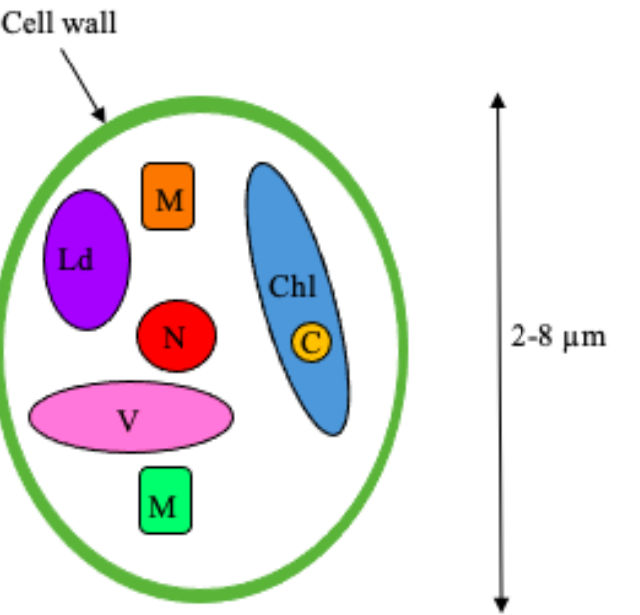
Figure 2. Basic structure of N. oculata . This graphical representation depicts the basic structure of N. oculata . It is comprised of a fibrous skeleton containing a single chloroplast. The cell wall contains polysaccharide, protein, and lipid components packed in a shapeless mucilaginous material. M: mitochondria; Ld: lipid droplet; N: nucleus; V: vacuoles; Chl: chloroplast; C: chlorophyll.